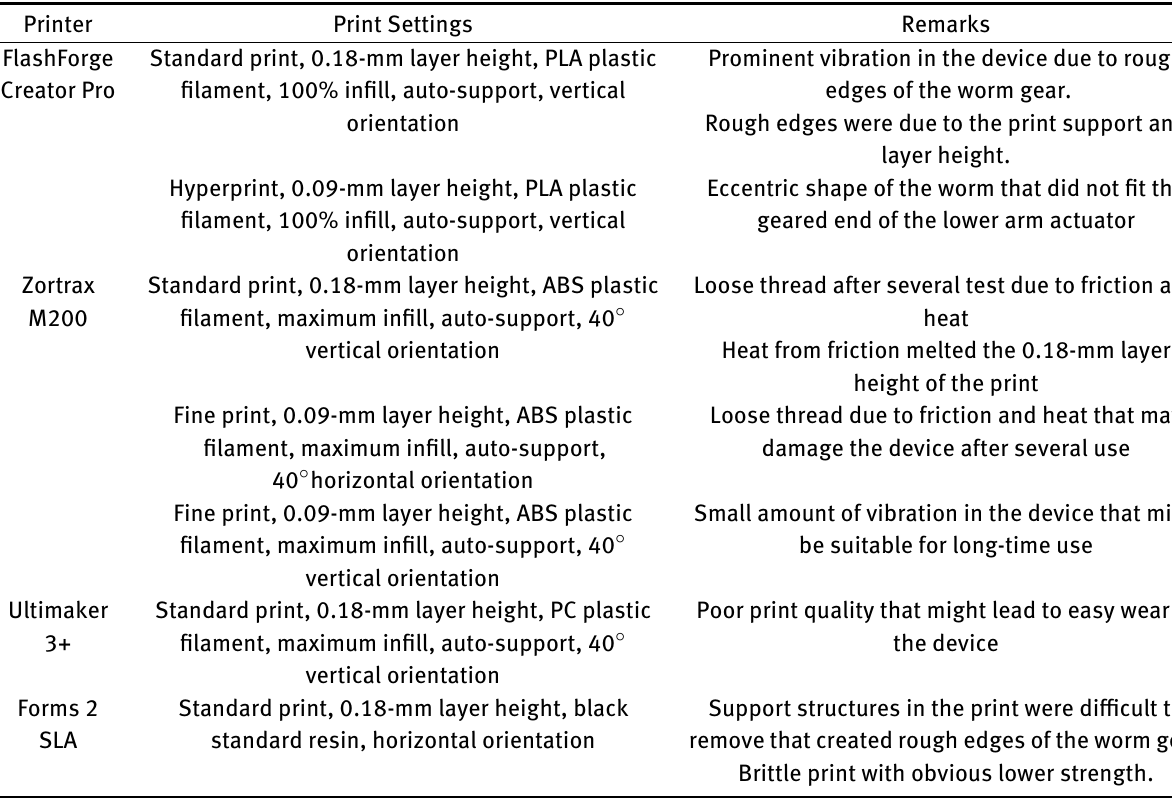
Table 3: Analysis of worm gear print quality under different settings